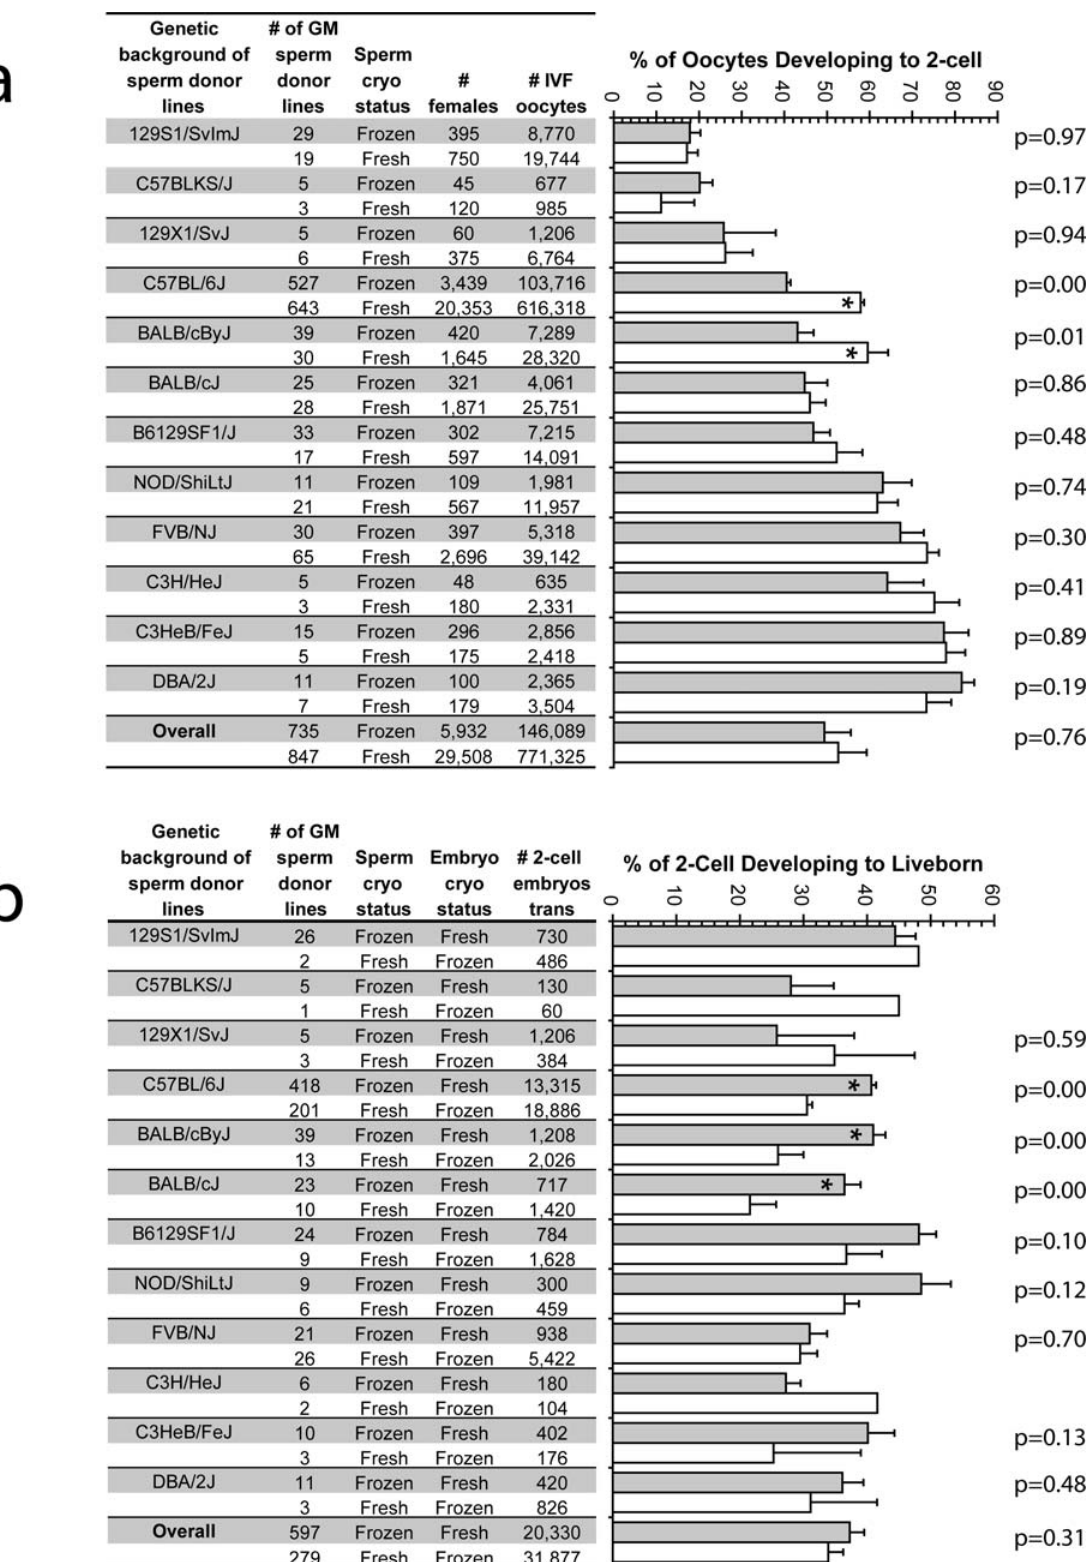
Efficient Mouse Sperm Cryo.